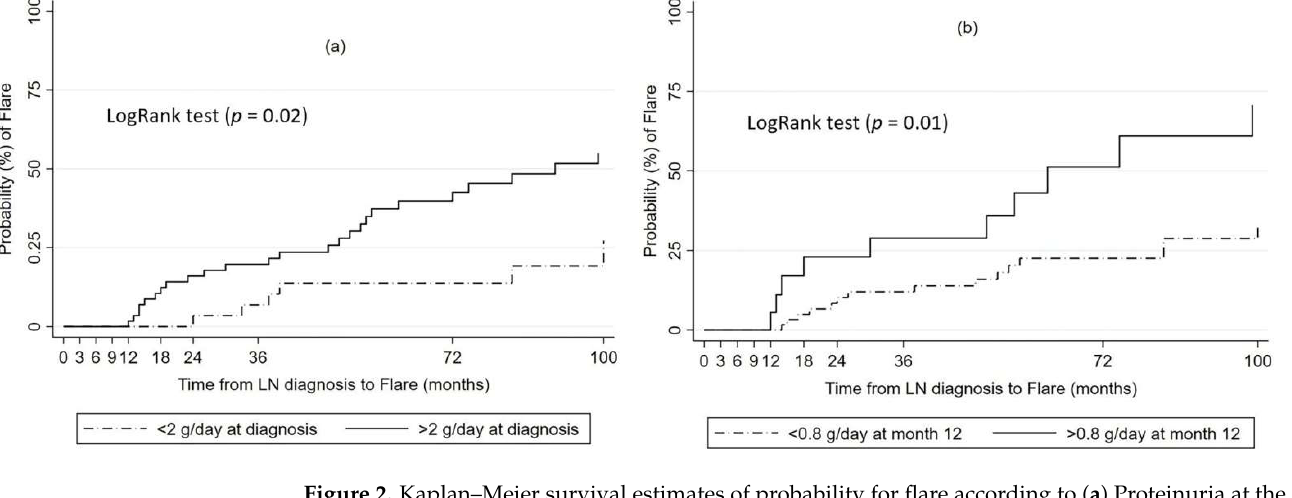
Figure 2. Kaplan–Meier survival estimates of probability for flare according to ( a ) Proteinuria at the time of LN diagnosis, ( b ) Proteinuria at 12 months. Table 3. Predictors of flares.